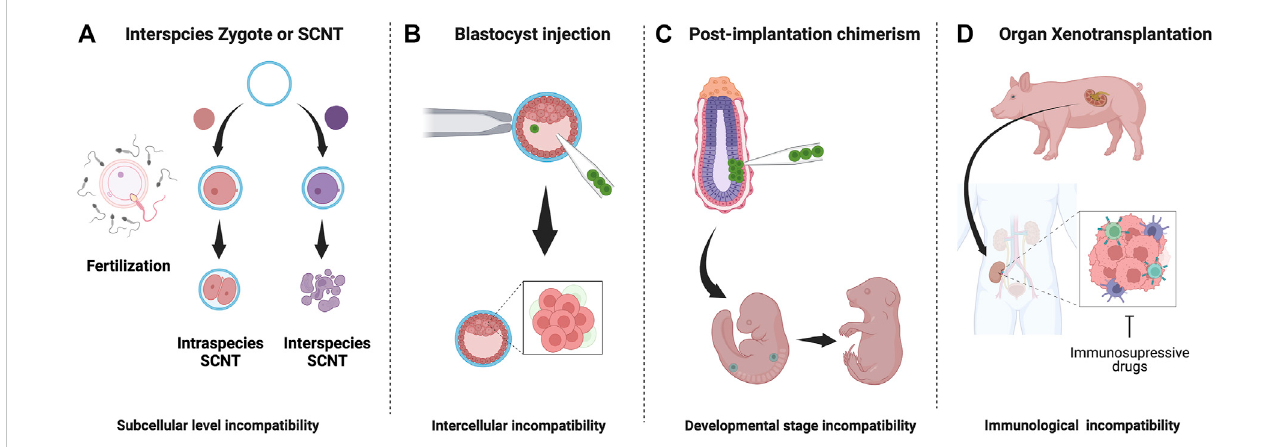
FIGURE 1 Interspecies embryo incompatibilities and barriers in interspecies chimerism: (A) Interspecies zygotes cannot reprogram and fail to develop due to subcellular level incompatibilities (B) Cell competition eliminates less fi t (donor) cells donor cells in host blastocyst (C) Stage-matching of donor cells is challenging and unknownfactor contribute to apoptosis of donor cells (D) Recipient immune system reacts stronglyagainstgraft tissue/organ. Despite long- term immunosuppression, organ failure